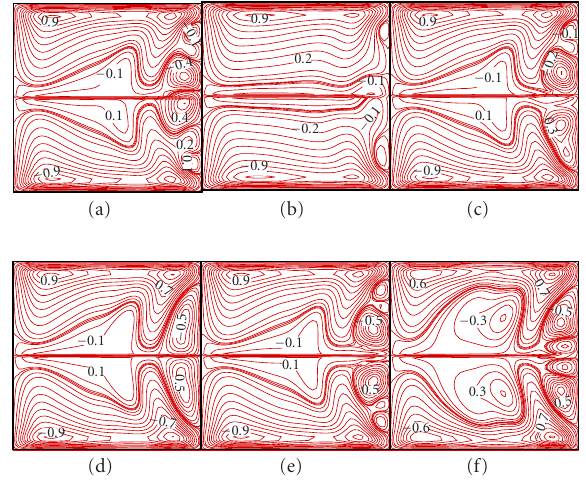
Figure 4: Typical secondary-flow patterns of six solutions among thirty nine solutions at L 2 = − 11 . 7 ( σ = 0 . 02, Pr = 0 . 7, Dk = 300, and L 1 =